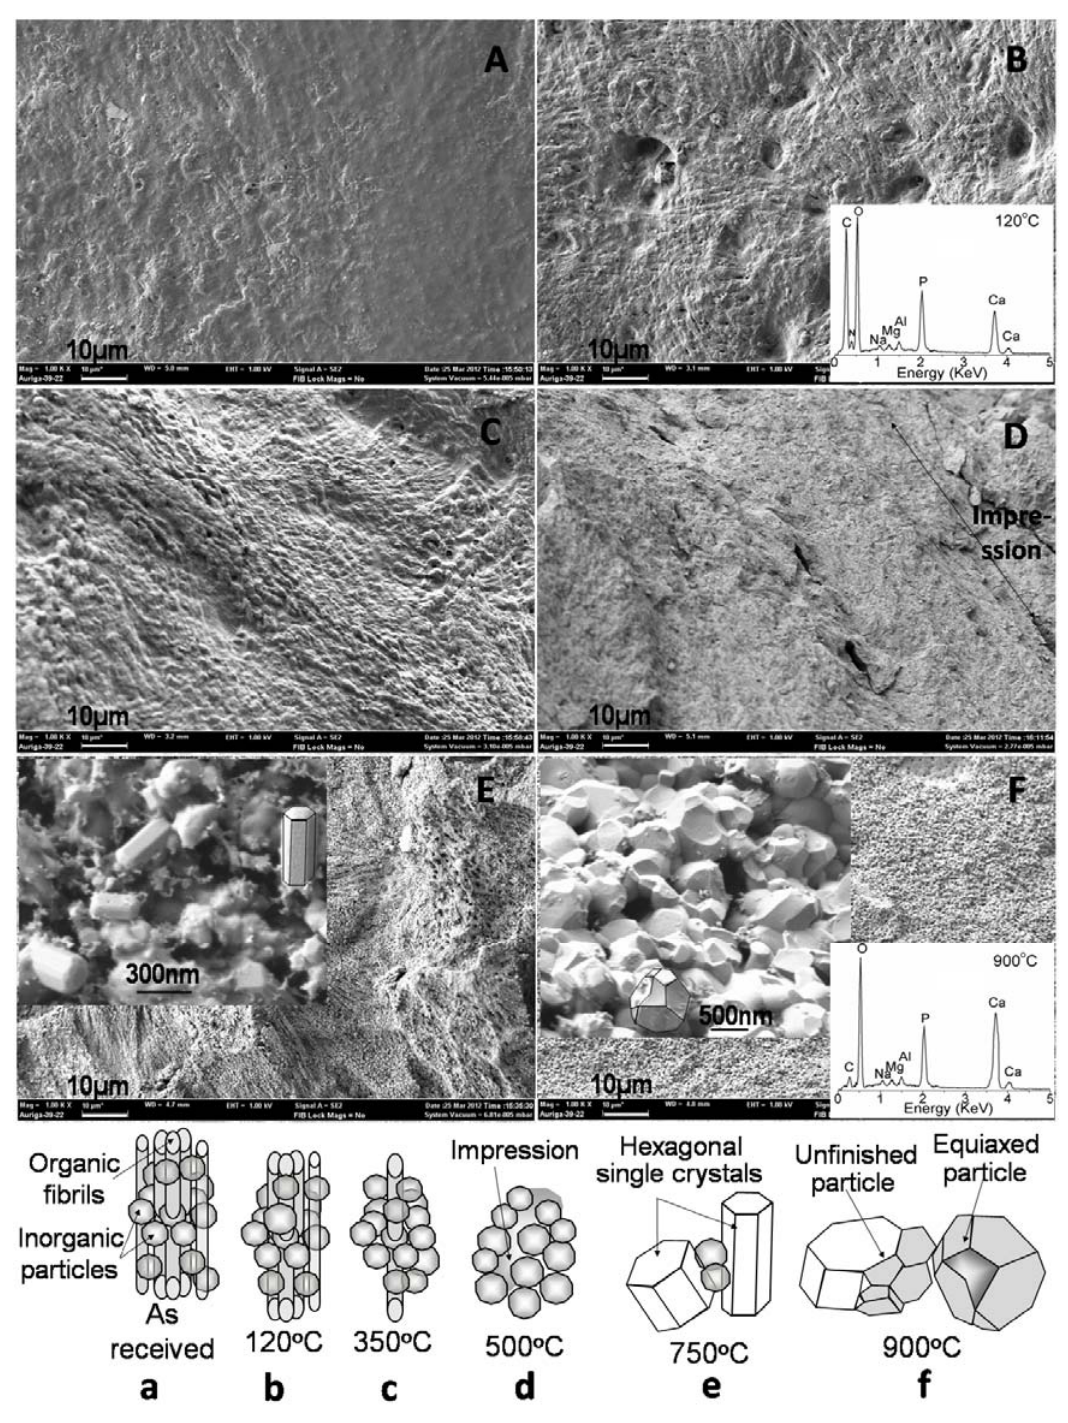
Figure 4. Scanning electron microscopy (SEM) micrographs and corresponding schematic steps of ( A & a ) as-received bovine bone and heat treated bone at ( B & b ) 120, ( C & c